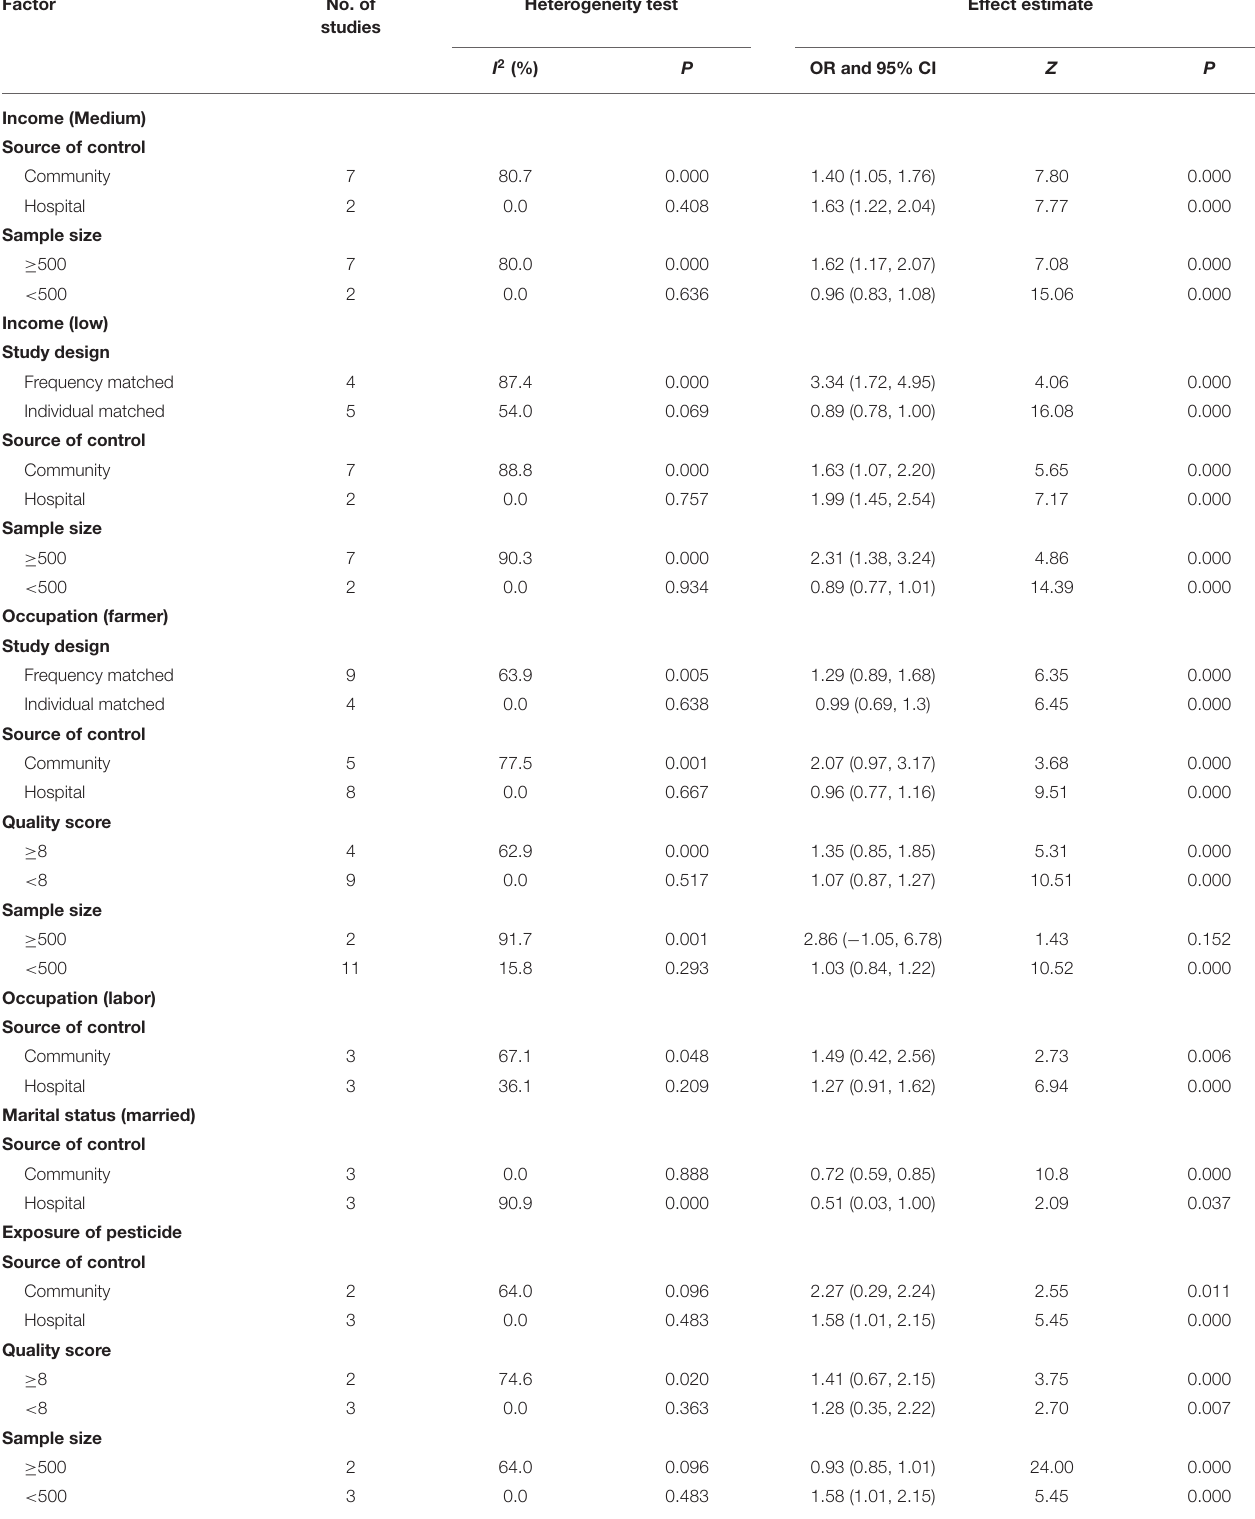
TABLE 2 | The result of subgroup analysis of some significant factors. Factor No. of